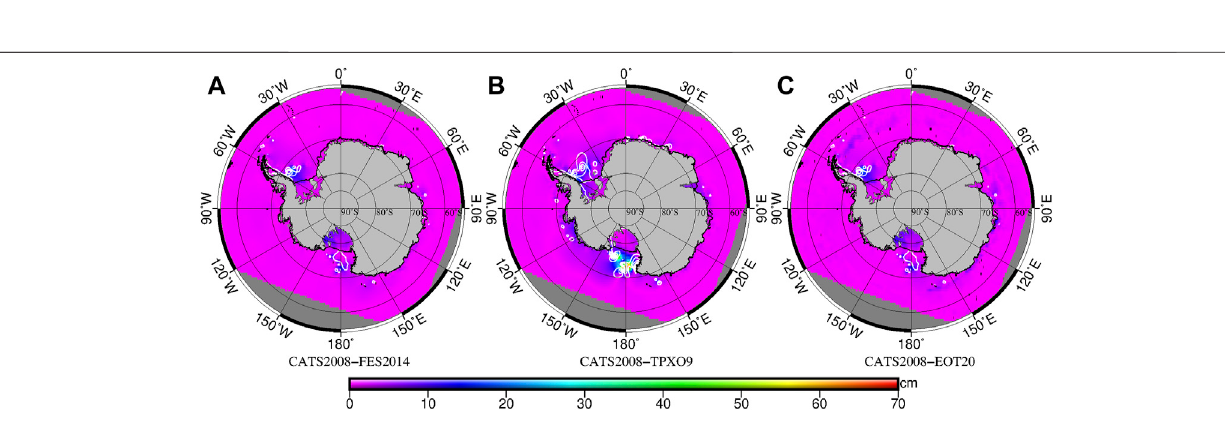
Frontiers in Earth Science |